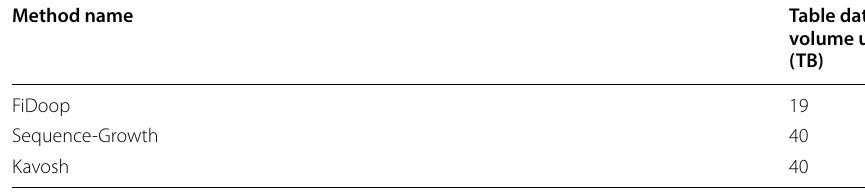
Table 22 Memory usage